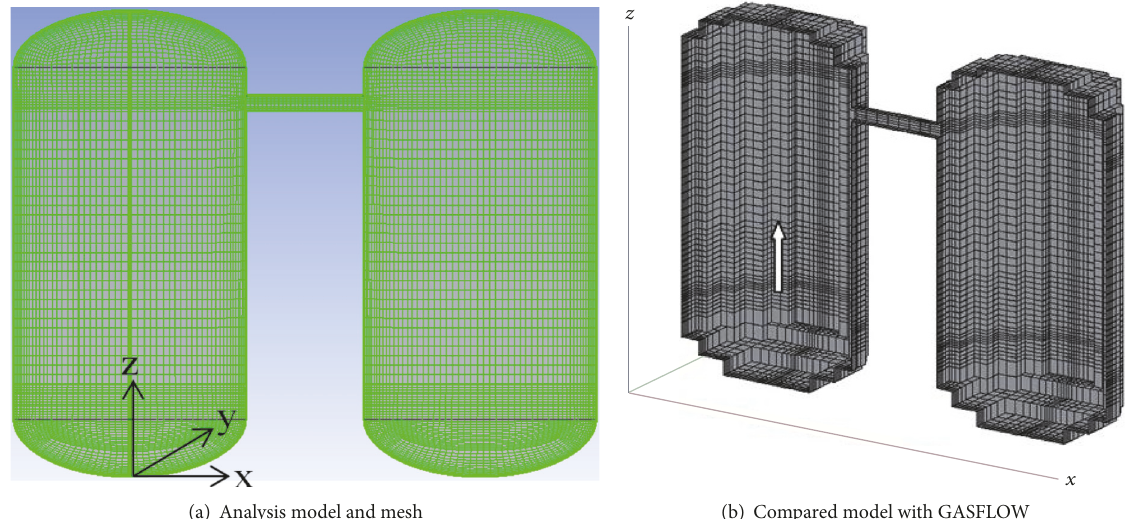
Figure 1: Geometric model built by both